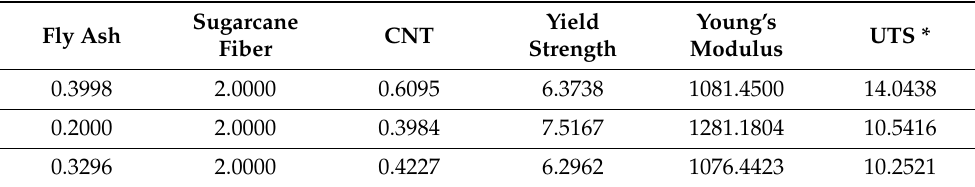
Table 6. Optimizing the objectives {YS, YM} with constraints imposed on input parameters {fly ash, SCF, CNT} ≥ 0.2.